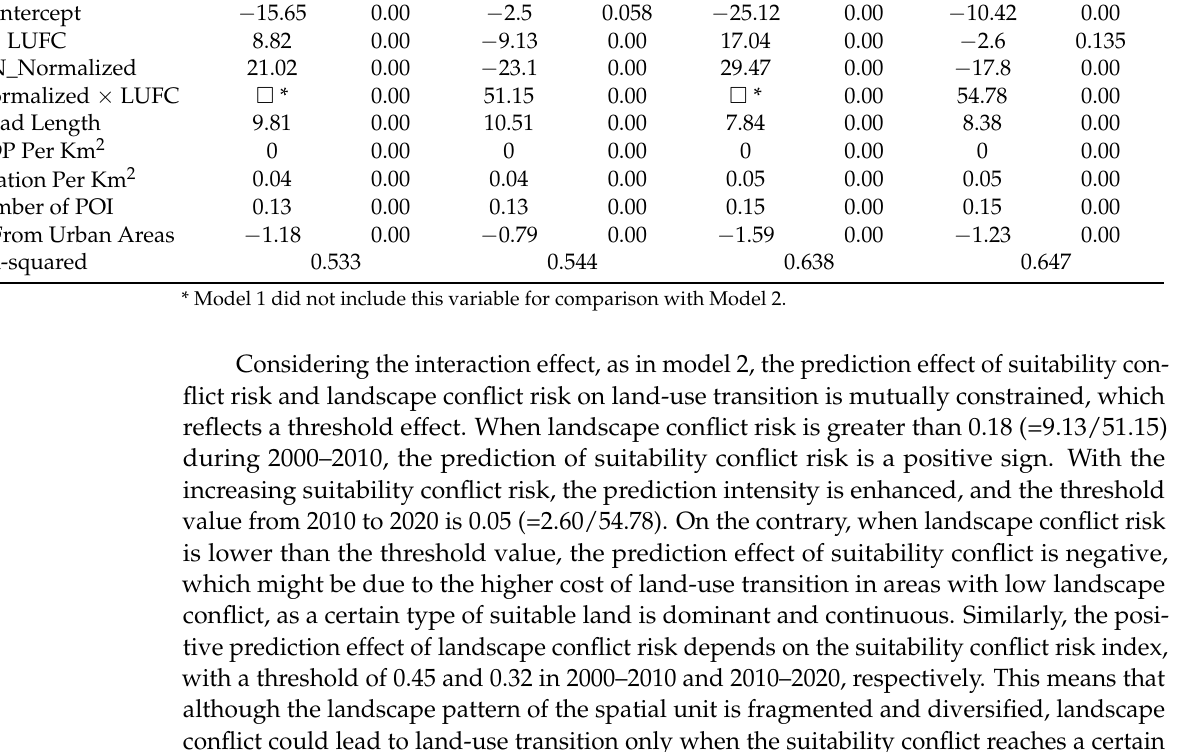
Table 5. Regression analysis of the driving factors of total land-use transition.